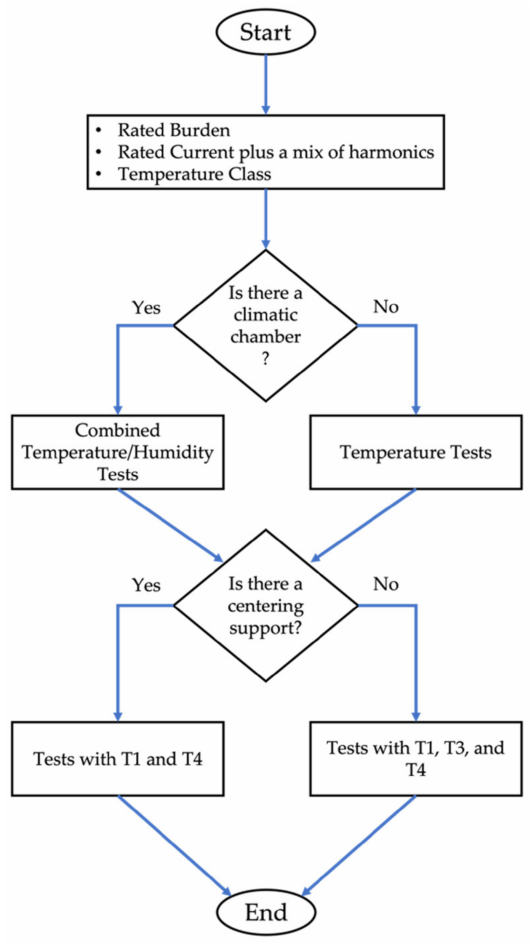
Figure 11. Type test design decision